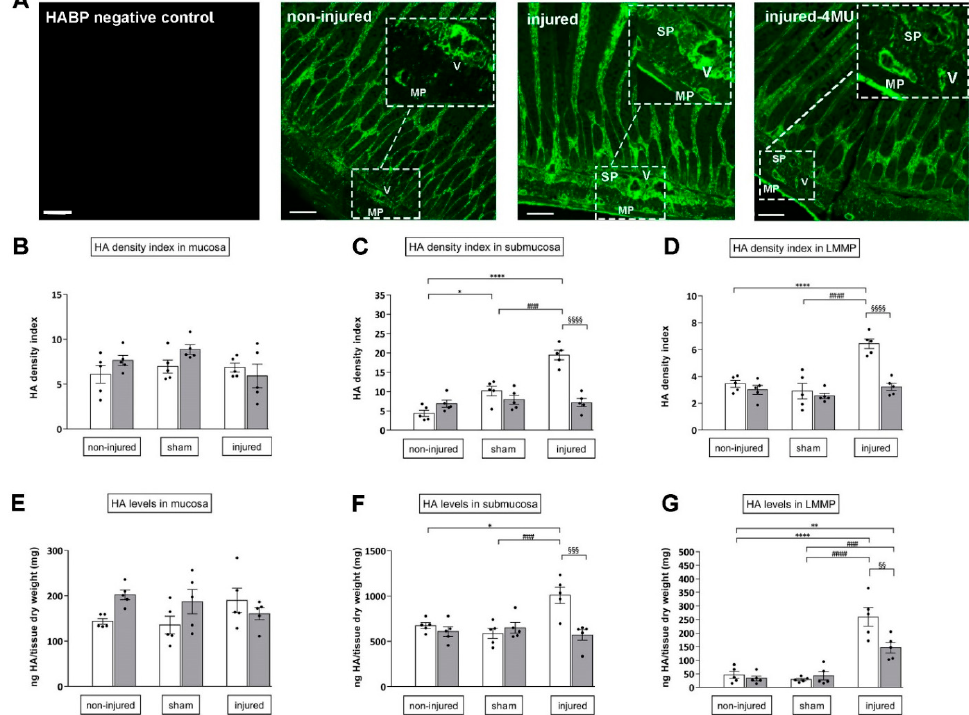
Figure 3. Immunofluorescence staining and ELISA assay reveal enhanced HA levels in the submucosa and LMMPs after IRI. ( A ) Confocal microphotographs of HA staining in rat small intestine cross-sections obtained from a negative control, non-injured, non-treated injured and 4-MU-treated injured groups (V: vessel; MP: myenteric plexus; SP: submucosal plexus). Scale bar 100 µm. ( B – D ): HA density index in the mucosa ( B ), submucosa ( C ) and longitudinal muscle with the myenteric plexus (LMMP) preparations ( D ) obtained in non-injured, sham and injured groups with (grey columns) or without (white columns) 4-MU treatment. ( E – G ) HA levels quantified with ELISA assay in rat small intestine mucosa ( E ), submucosa ( F ) and LMMP preparations ( G ), obtained from the different experimental groups, with (grey columns) or without (white columns) 4-MU. HA levels expressed as ng of HA normalized per mg of dry tissue weight. Data are reported as mean ± SEM. N = 5 rat/group. **** ,§§§§,#### p < 0.0001, ###,§§§ p < 0.001, ** ,§§ p < 0.01, * p < 0.05 by one-way ANOVA with Tukey’s post hoc